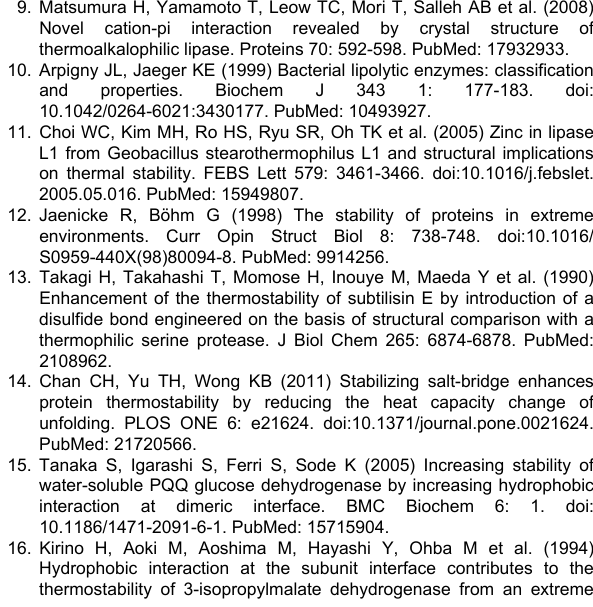
Figure S5. The RMSD analyses of molecular dynamics simulations.